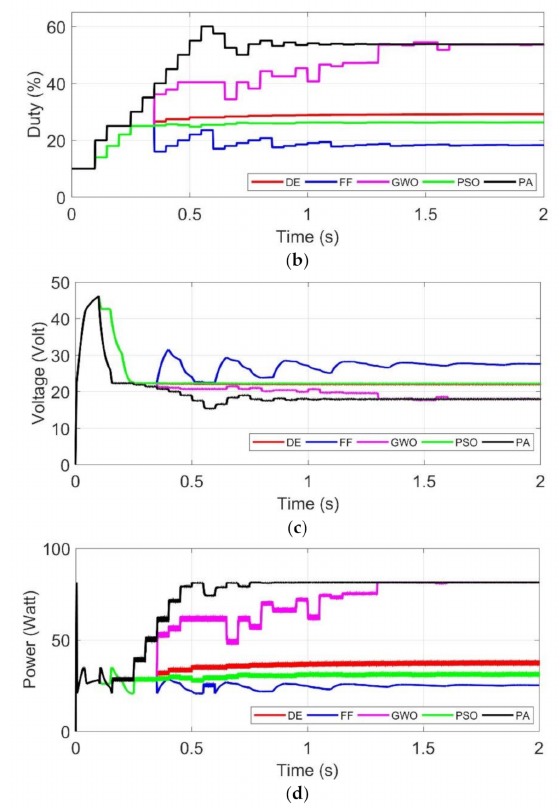
Figure 14. Test 6 ( a ) Initial particles ( b ) Duty cycle (%) ( c ) PV voltage (V) ( d ) PV power